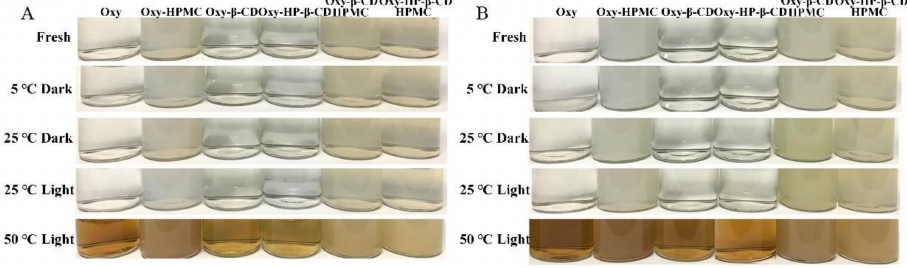
Figure 5. The visual appearance of Oxy, Oxy–HPMC, Oxy–CDs, and Oxy–CDs-HPMC solutions under different conditions during 30 days of storage. ( A ) Water; ( B ) acidic solution (pH